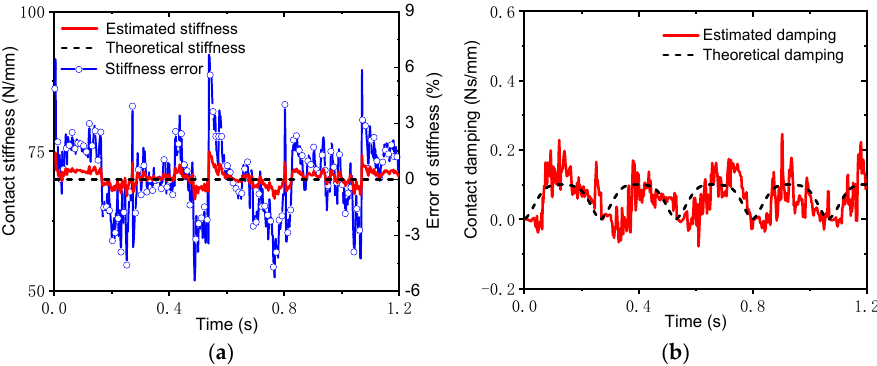
Figure 11. Estimates of contact stiffness and damping in virtual collisions. ( a ) Stiffness. ( b ) Damping.